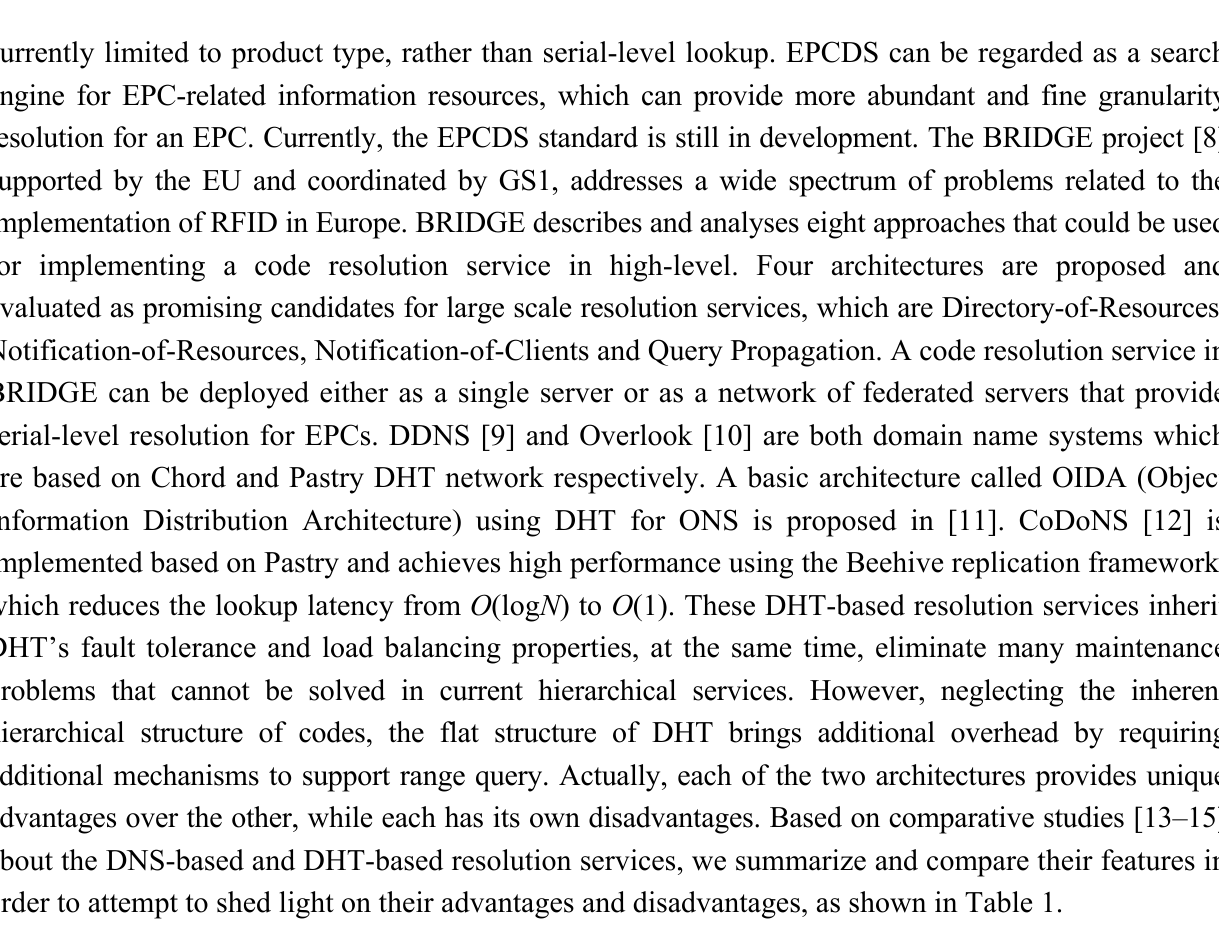
Table 1. The comparison between DNS-based and DHT-based code resolution